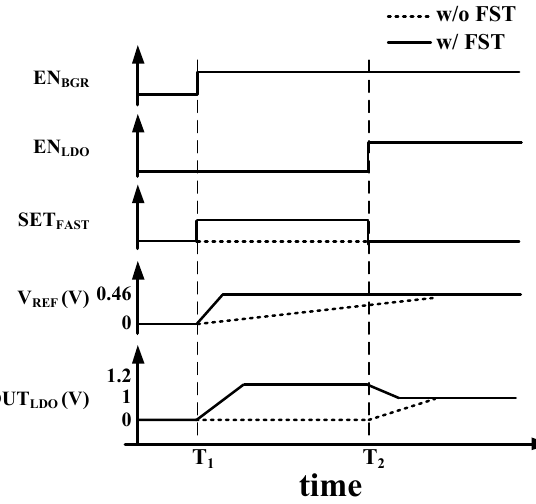
Figure 19. Timing diagram of the fast settling technique.